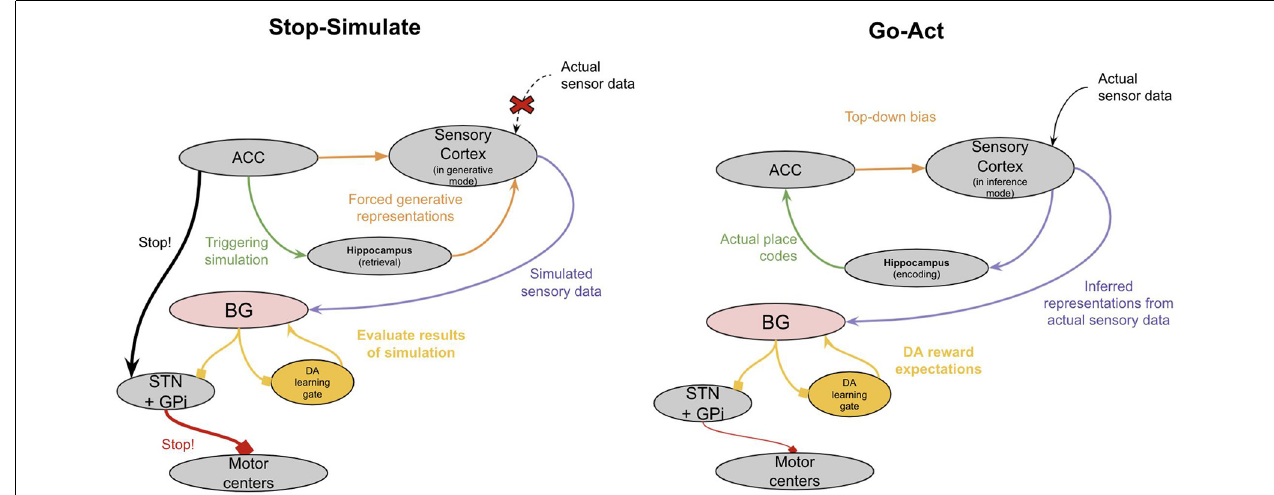
FIGURE 5 | A high-level proposal of how “Simulating” is implemented in the neocortex. See text for